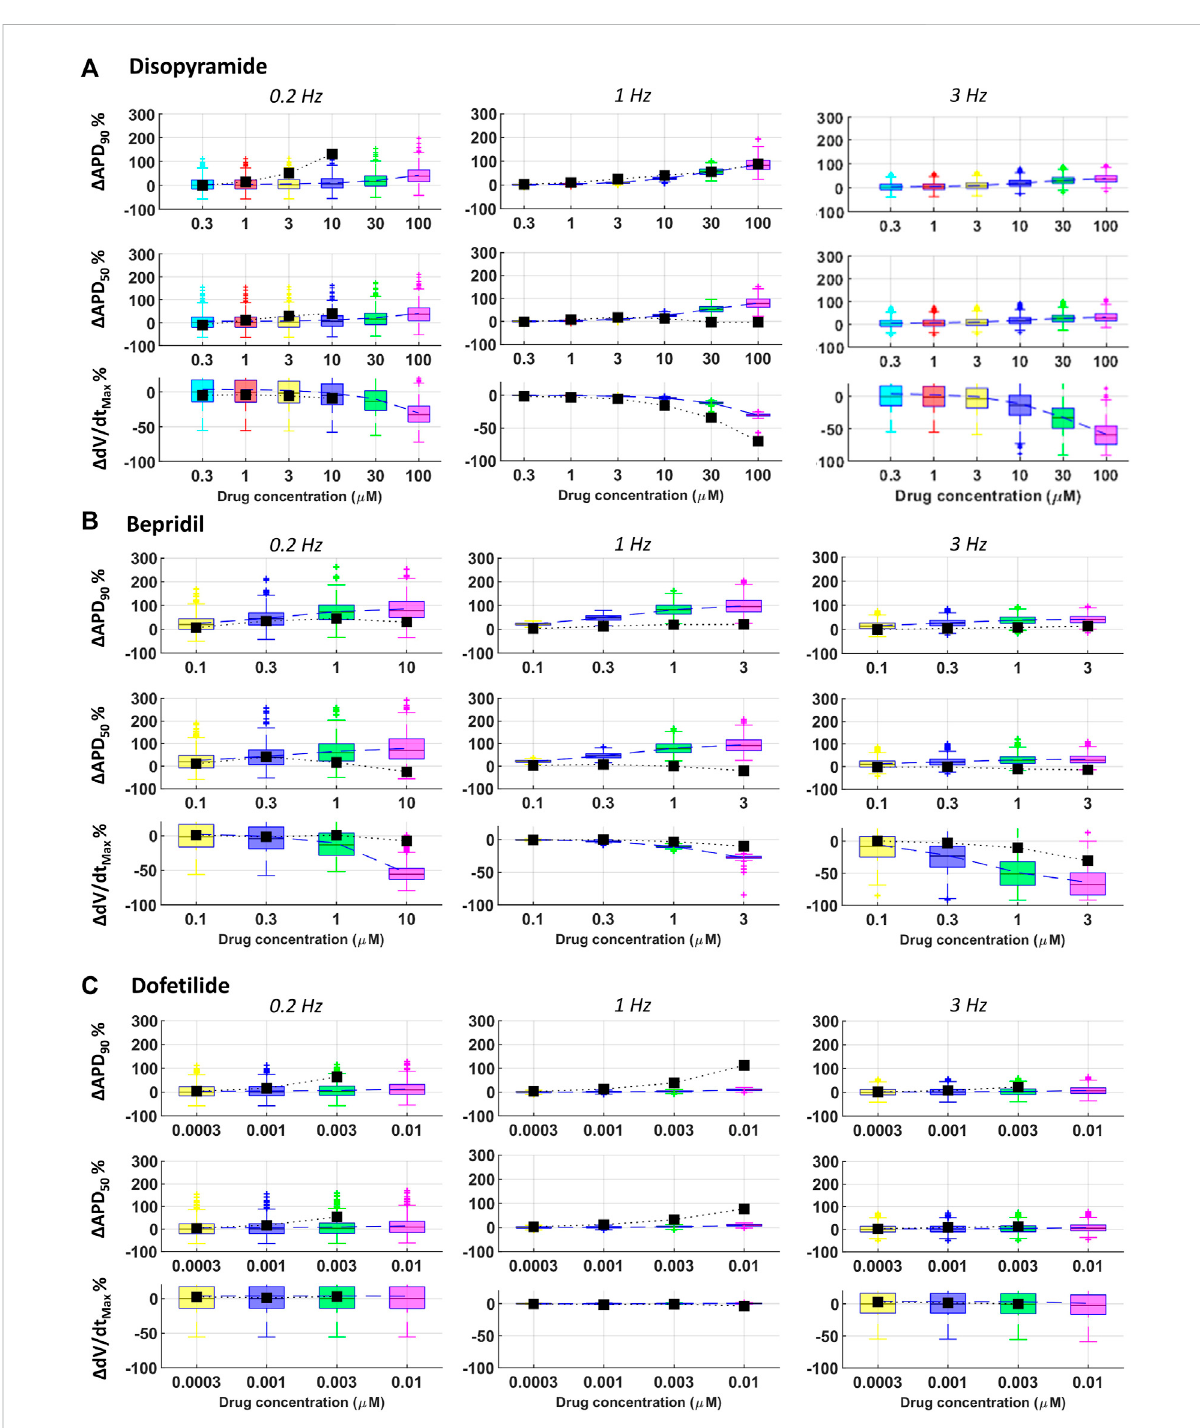
FIGURE 7 Comparison betweensimulated and experimental dose-response curves for APD 90 , APD 50 and dV/dt MAX , for three representativecompounds, at all pacing frequencies: (A) disopyramide; (B) bepridil; (C) dofetilide. Boxplots: human simulations at different concentrations (one color per concentration): on each box, the central mark is the median of the population, box limits are the 25 and 75th percentiles, and whiskers extend to the mostextremedatapointsnotconsideredoutliers,plottedindividuallyasseparatecrosses.Blacksquares:meanvaluesofthe invitro